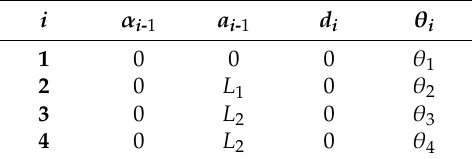
Table 1. Denavit-Hartenberg (DH) parameters of the lower-limb